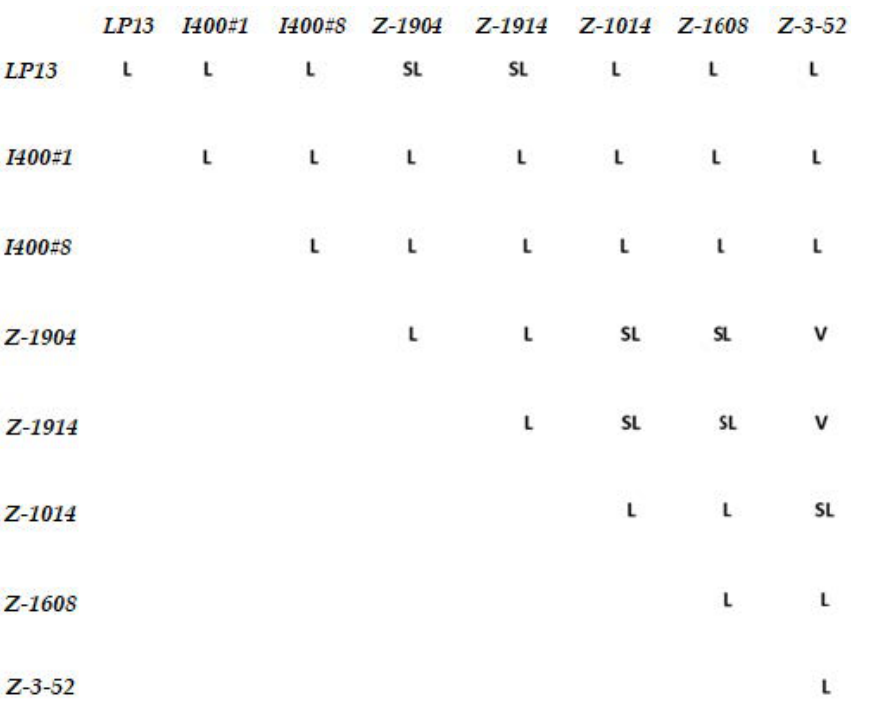
Figure 2. Results of inter se complementation analysis of zep alleles. The mutant third chromosomes were balanced with either TM3, Sb Ser, or TM3 Ser. A minimum of 100 progeny per cross was examined. L = lethal; SL = semi-lethal (less than 50% of expected transheterozygous or homozygous progeny relative to balancer progeny); V = viable.